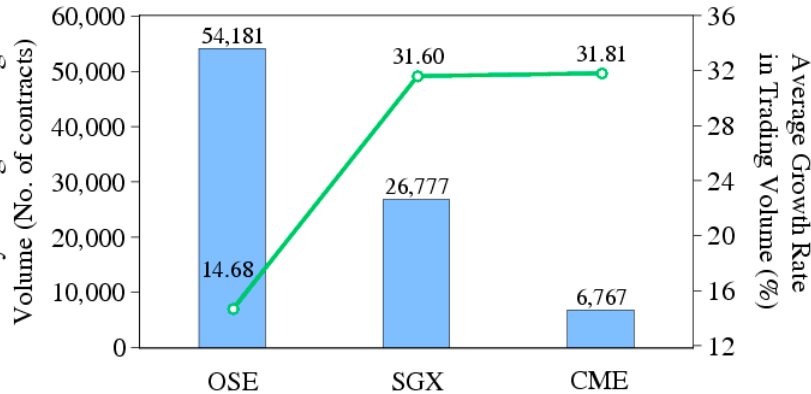
Figure 1. Nikkei futures trading volume. Notes: The left axis shows the daily average trading volume, calculated as the average number of contracts traded daily. Since the contract size of SGX futures is half that of OSE futures (Table 1), SGX volume is halved to facilitate direct comparison with OSE volume. CME volume is unadjusted due to dollar denomination. The right axis shows the average growth rate in trading volume, calculated as the average percent change in the number of contracts traded